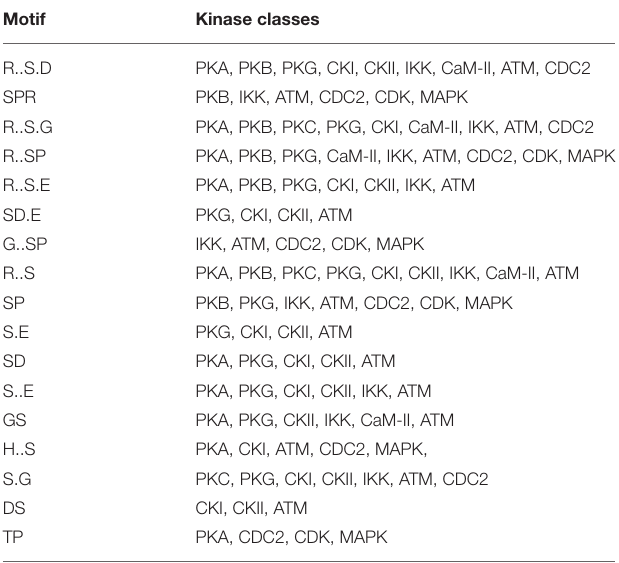
TABLE 2 | Types of kinases represented by the 17 motifs listed in Table 1 as determined by